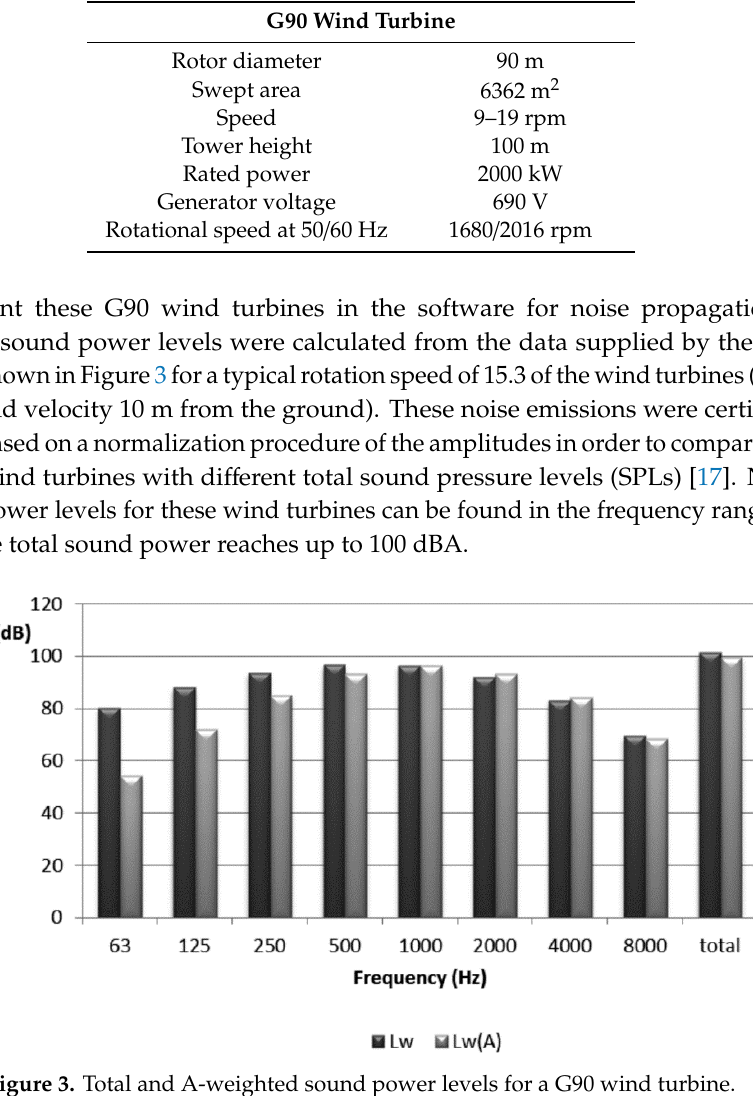
Table 1. G90 wind turbine characteristics.